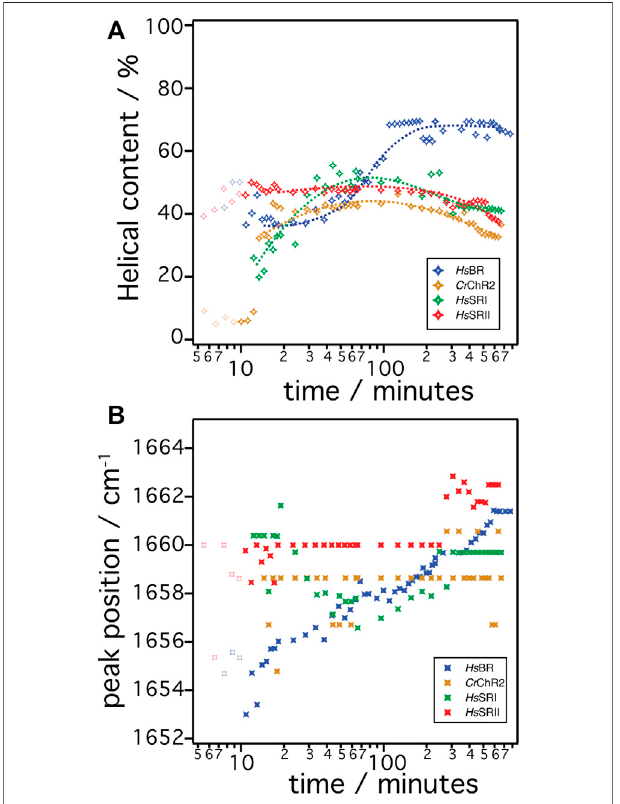
FIGURE5|(A) The α -helicalcontentintheamideIbandovertimeduring the cell freeexpression isshown. The helicalcontentisdeterminedby dividing thepeakareaofthe α -helicalcomponentbythepeakareaofthecumulativeof all components in amide I band. (B) The peak position of the α -helical components are plotted over time during the cell free expression. The color code represents Hs BR (blue), Cr ChR2 (orange), Hs SRI (green), and Hs SRII